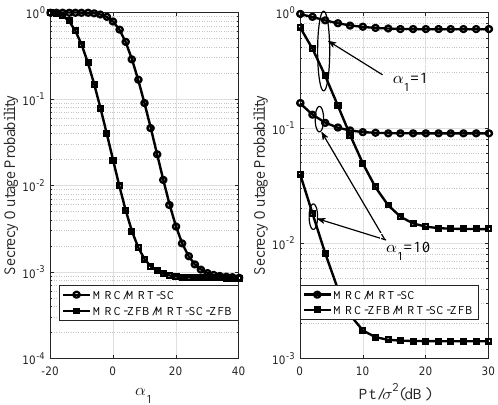
Figure 7. Secrecy outage probability of two schemes for different α 1